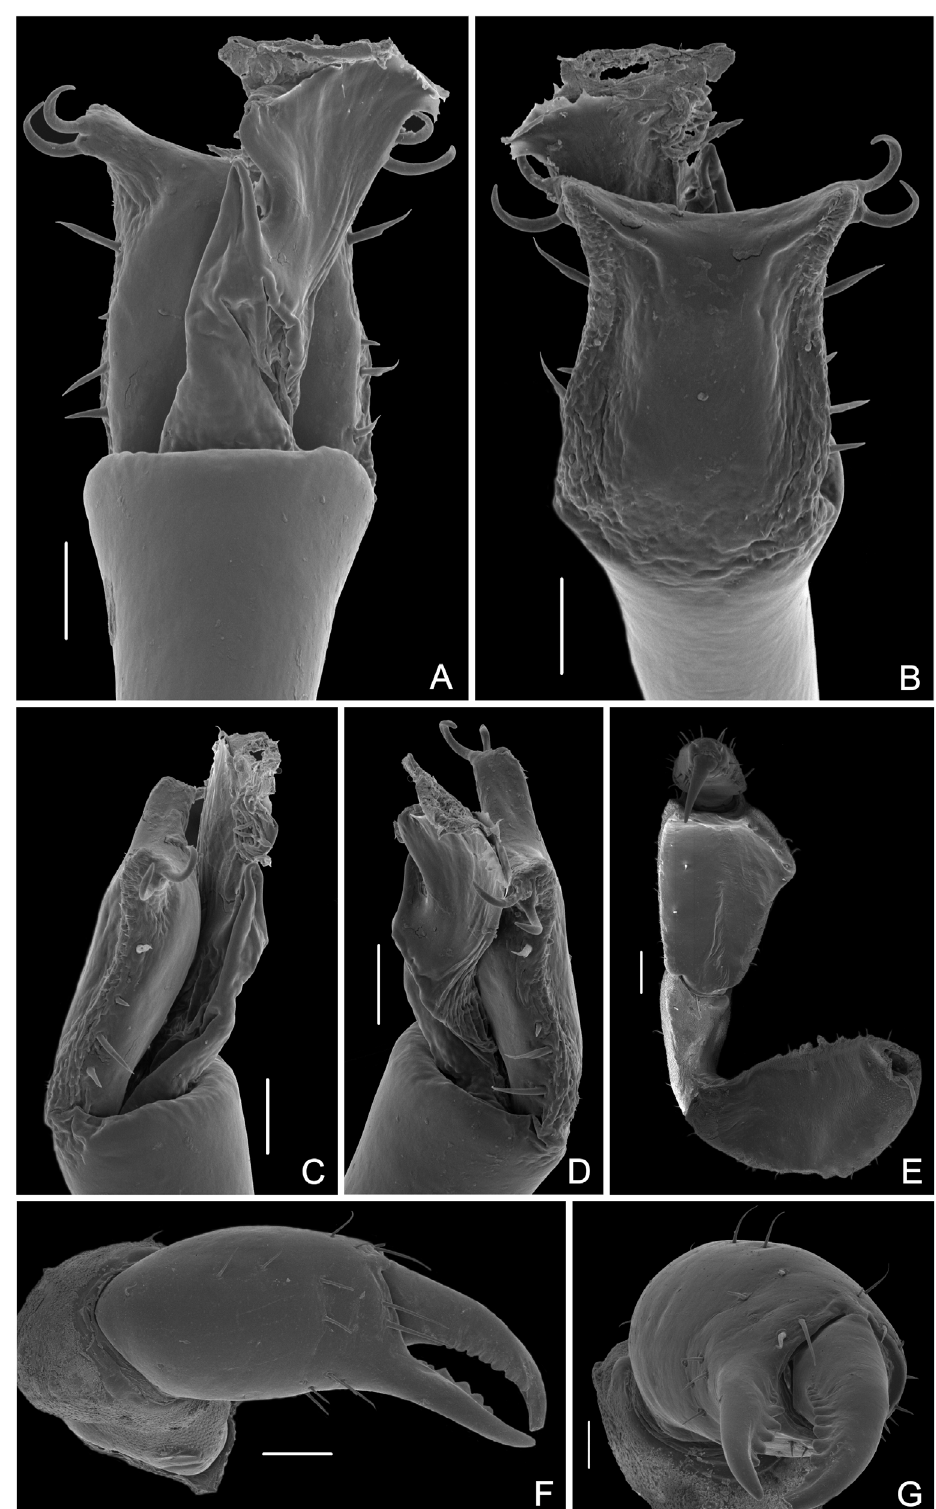
Fig. 12. Libitia iguaque sp. nov., ♂ (MNRJ 17379). A–D . Distal part of penis. A . Dorsal view. B . Ventral view. C . Left lateral view. D . Right lateral view. E . Right pedipalp, ventral view. F–G . Left chelicera, dorsal and frontal view, respectively. Scale bars: A–D = 50 μm; E–F = 200 μm; G = 100